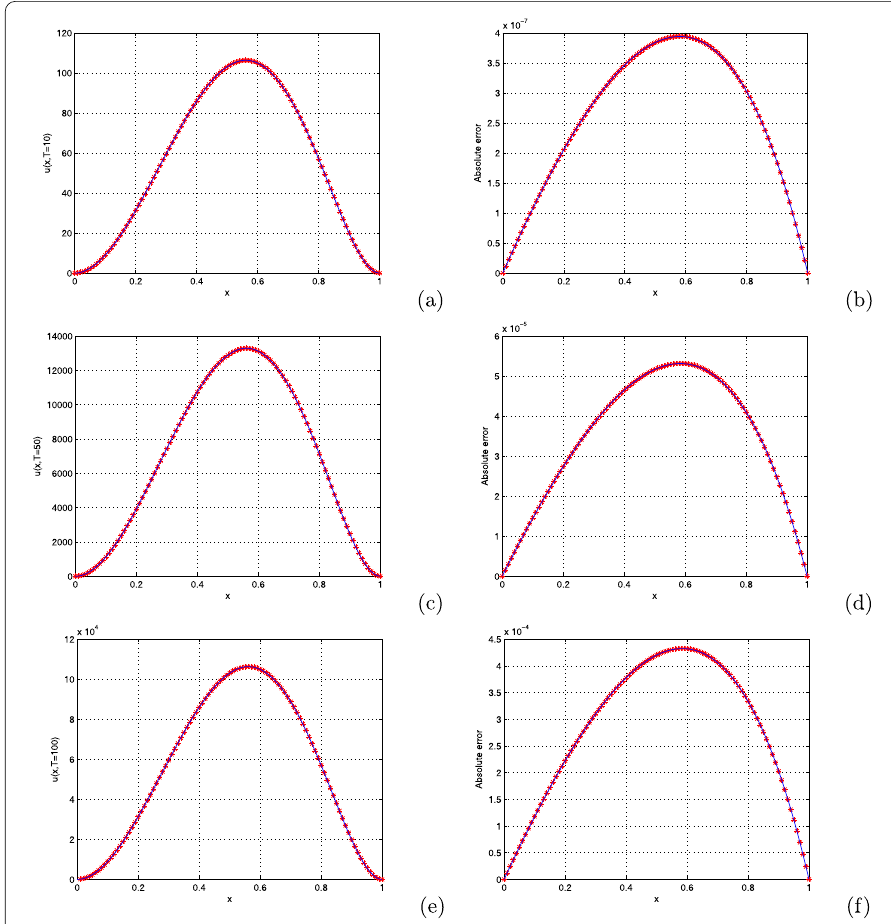
Figure 2 The exact solution and numerical solution at different time ( T = 10,50,100) with α = 0.5, h = 1/100, τ = 1/100 and corresponding error for Example 1. Dotted line: numerical solution, solid line: exact solution